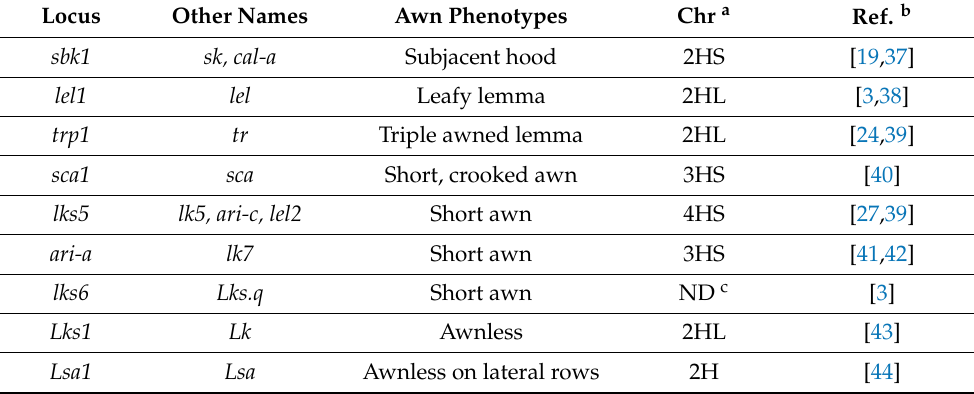
Table 2. Mapped genetic loci for awnness in barley.